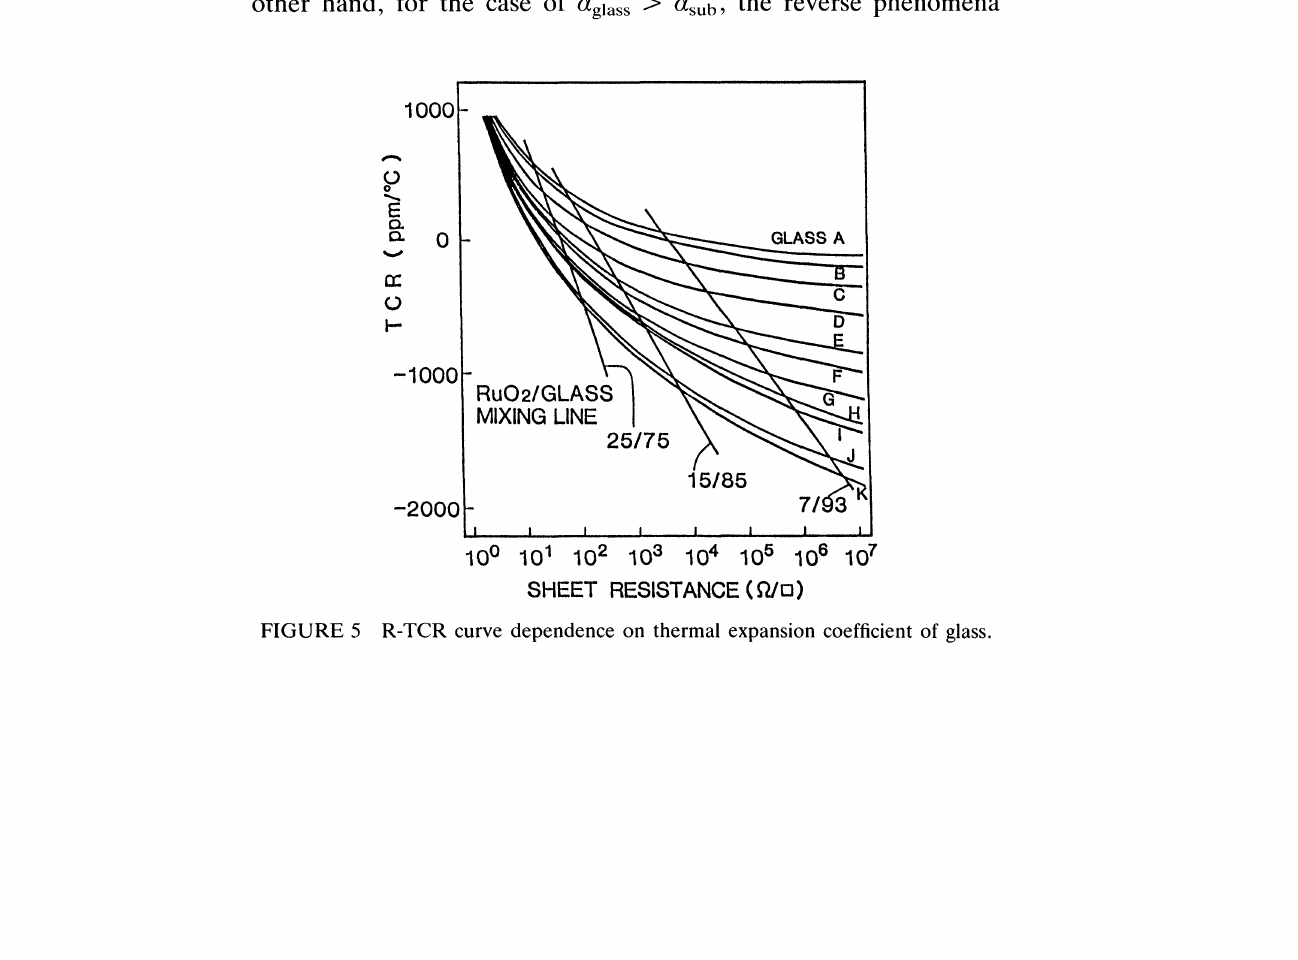
SHEET RESISTANCE (9./rn) R-TCR curve dependence on thermal expansion coefficient of